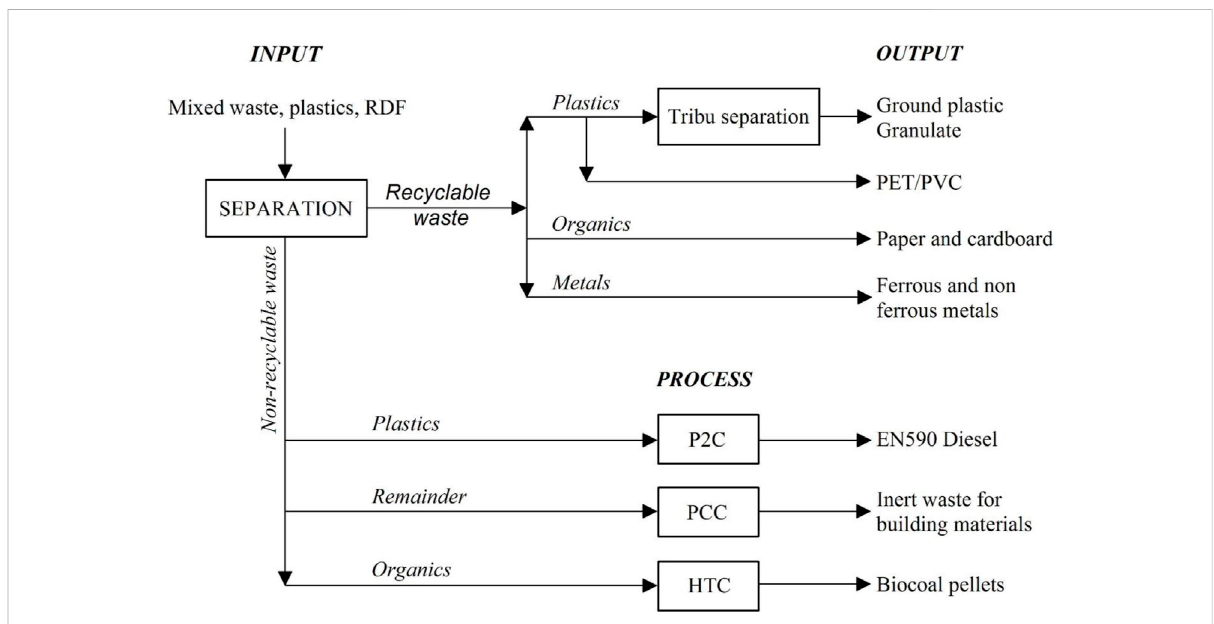
FIGURE 3 Flow sheet of Renasci Smart Chain Processing in Ostend. PET — polyethylene-terephthalate, PVC — polyvinyl chloride. P2C —